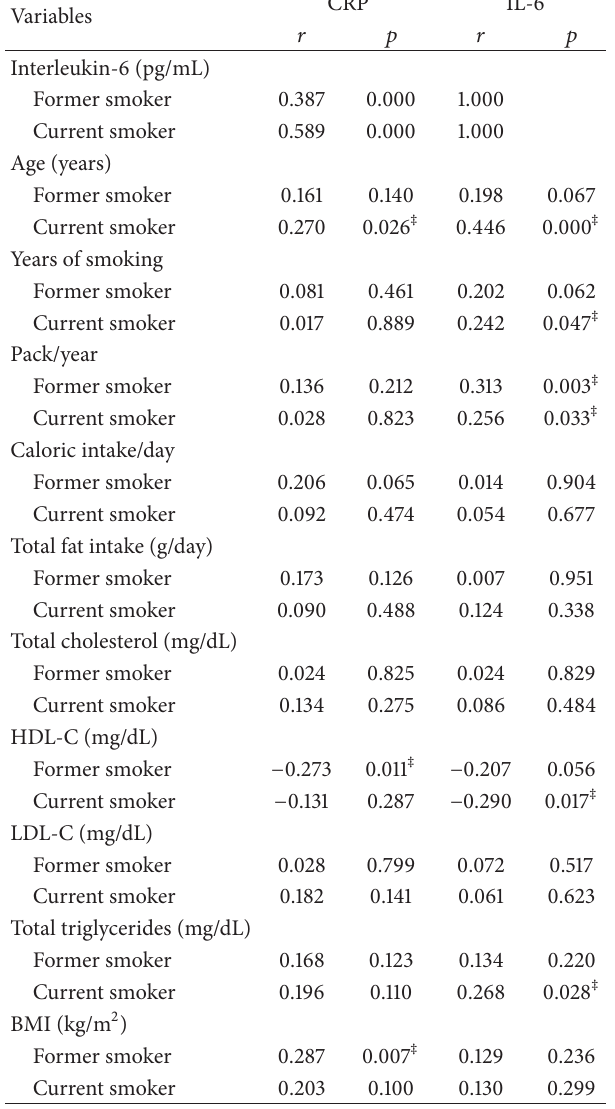
Table 4: Stepwise regression analysis for CRP and IL-6 by smoking